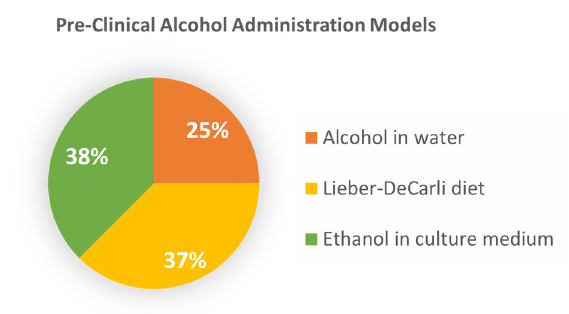
Figure 6. Alcohol exposure models used in preclinical studies. The percentage of studies is noted for the in vivo assessment of colorectal liver metastasis in animals fed alcohol in water or in Lieber– DeCarli diet; and colorectal cancer cell cultures treated in vitro with various concentrations of ethanol. Table 3. Characteristics of preclinical studies.